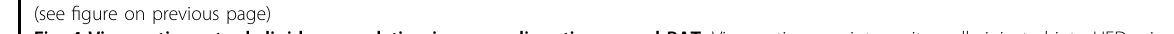
Fig. 4 Vinpocetine retards lipid accumulation in mouse liver tissues and BAT. Vinpocetine was intraperitoneally injected into HFD mice, as described in the “ Materials and methods ” . a Both NFD-fed and HFD-fed mice were sacri fi ced after the 10-week experimental diet period. Then, the liver weight of these mice was measured. b H&E staining of liver sections was performed in each indicated group treated with or without vinpocetine for 10 weeks as described in the “ Materials and methods ” . c Liver tissues were collected, and tissue lysates were prepared as described in the “ Materials and methods ” . The mRNA expression of FABP4 and FASN was detected by qPCR analysis. β -actin was used as a normalization control. d Both NFD-fed and HFD-fed mice were sacri fi ced after the 10-week experimental diet period. Then, the BAT weight was measured using a weighing scale. e H&E staining of BAT sections from mice was performed in the indicated group treated with or without vinpocetine for 10 weeks as described in the “ Materials and methods. ” f BAT was collected, and tissue lysate was prepared as described in the “ Materials and methods ” The protein expression of UCP1 and PGC-1 α was detected by western blotting. β -actin was used as a load control. g BAT was collected, and tissue lysate was prepared as described in the “ Materials and methods ” . The mRNA expression of UCP1 was detected by qPCR analysis. β -actin was used as a normalization control. Data are presented as the mean ± SD ( n = 4 for NFD-fed mice and n = 8 for HFD-fed mice); * P < 0.05, ** P < 0.01, and *** P